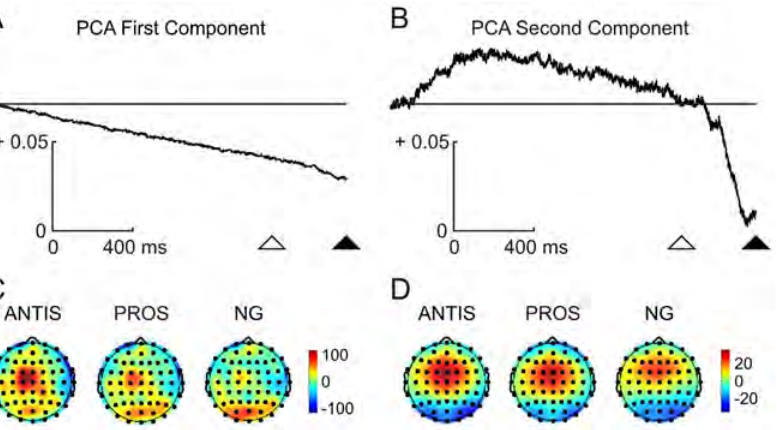
Figure 4. Principal component analysis (PCA) of the event-related potentials during the preparatory and gap periods. The first PCA component (A) displays a trend line during all the preparatory period whereas the second (B) shows positivity during the instructive period and a sharp negativity during the gap period. These two PCA components explained 79% and 7% of the variance, respectively. Scalp component scores for the first and second components of the PCA during antisaccadic (ANTIS), prosaccadic (PROS) and no-go (NG) tasks are shown in C and D, respectively. Please note that the occipital component is only present in the first component.